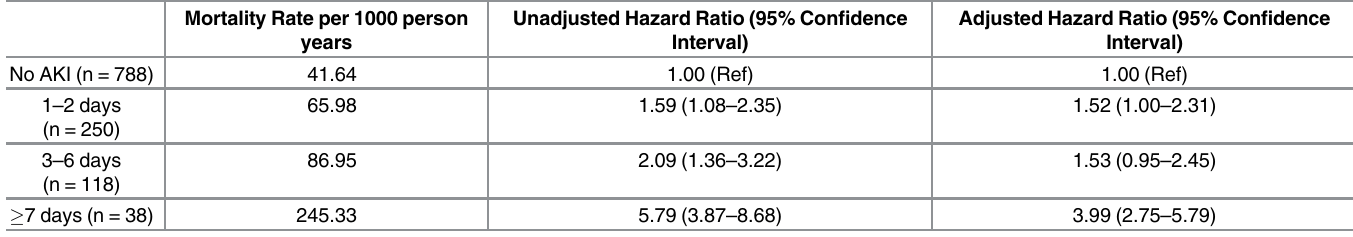
Table 5. Association of Duration of Acute Kidney Injury with Mortality during Follow-up Period. Mortality Rate per 1000 person